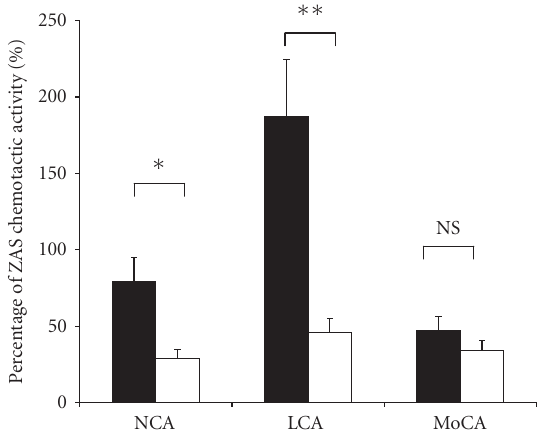
Figure 2. Chemotactic activity for neutrophiles (NCA), lym- phocytes (LCA), and monocytes (MoCA) expressed as percent- age of ZAS chemotactic potential in SF from patients with RA (closed bars) and OA (open bars); ∗ P < . 05, ∗∗ P < . 01; NS: not